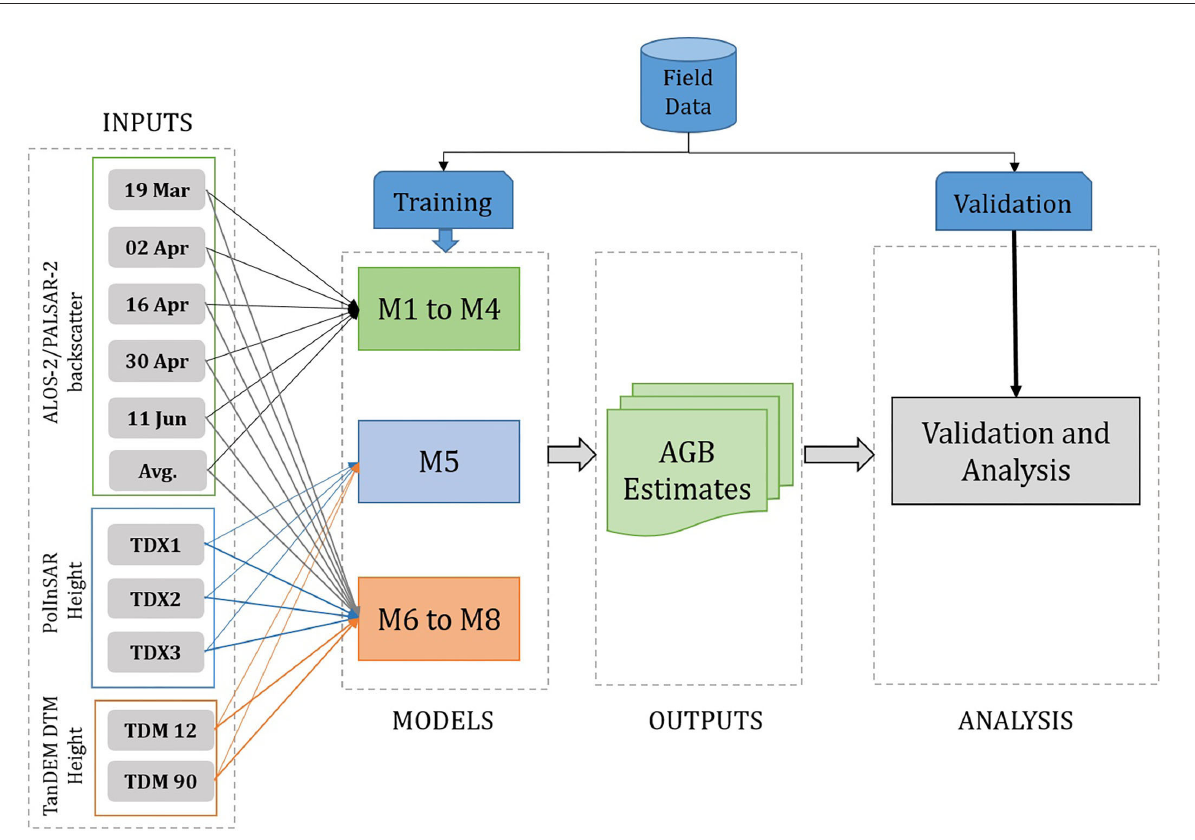
FIGURE7 Relation between PolInSAR height (left) and DEM estimated height (right) as a function of AGB. The PolInSAR heights are estimated from three TanDEM-X acquisitions and DEM estimated heights are from 12 m and 90 m TanDEM-X Global DEM and interpolated DTM.